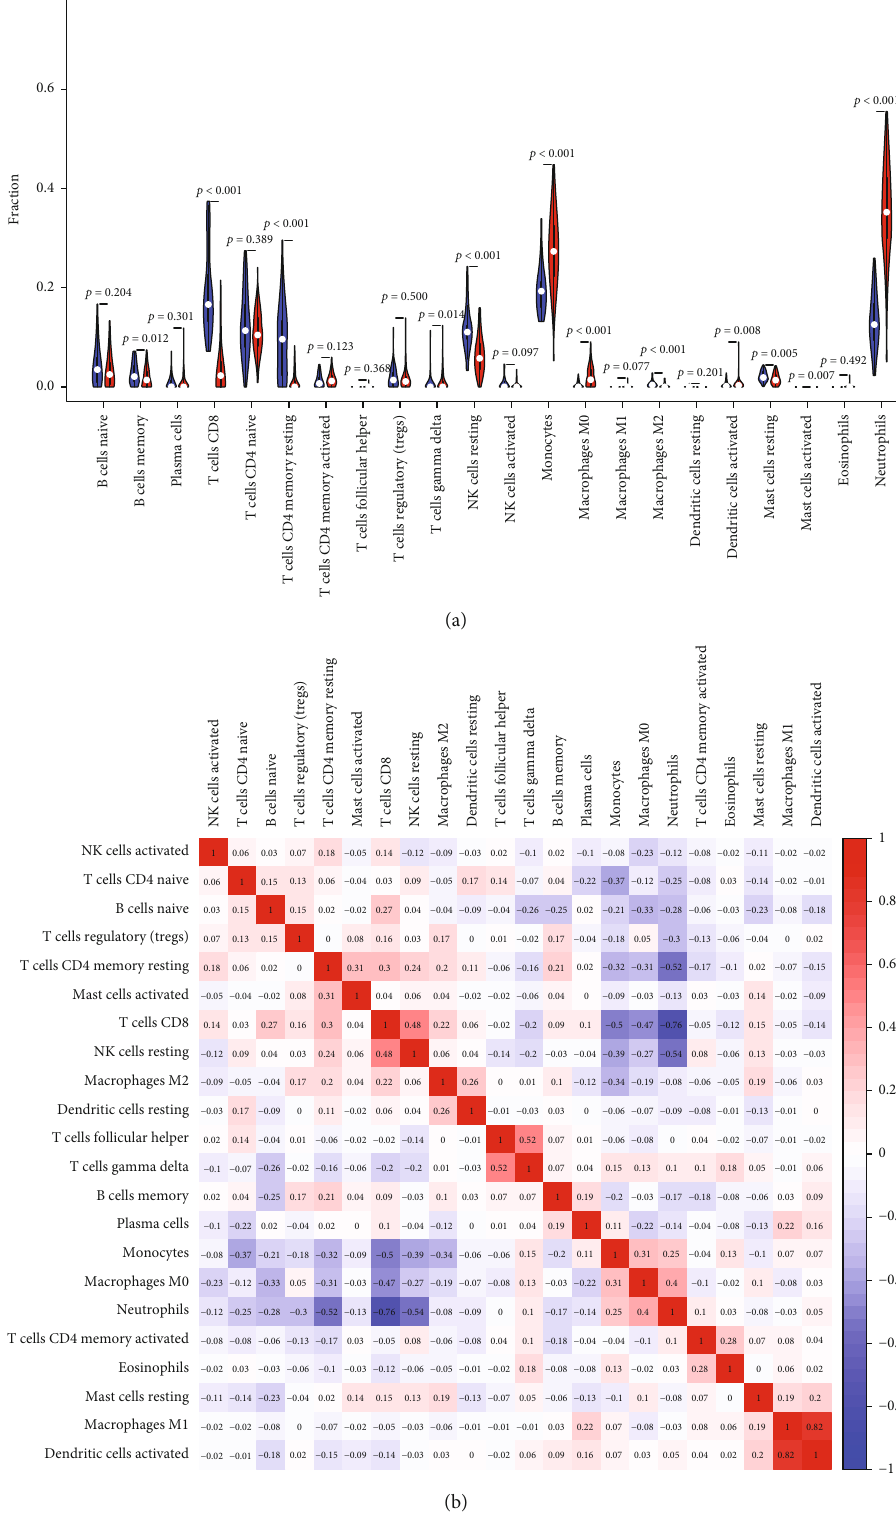
Figure 6: Distribution and visualization of immune cell in fi ltration. (a) Comparison of 22 immune cell subtypes between Kawasaki disease tissues and normal tissues. Blue and red colors represent normal and Kawasaki disease samples, respectively. (b) Correlation matrix of all 22 immune cell subtype compositions. Both horizontal and vertical axes demonstrate immune cell subtypes. Immune cell subtype compositions (higher, lower, and same correlation levels are displayed in red, blue, and white,